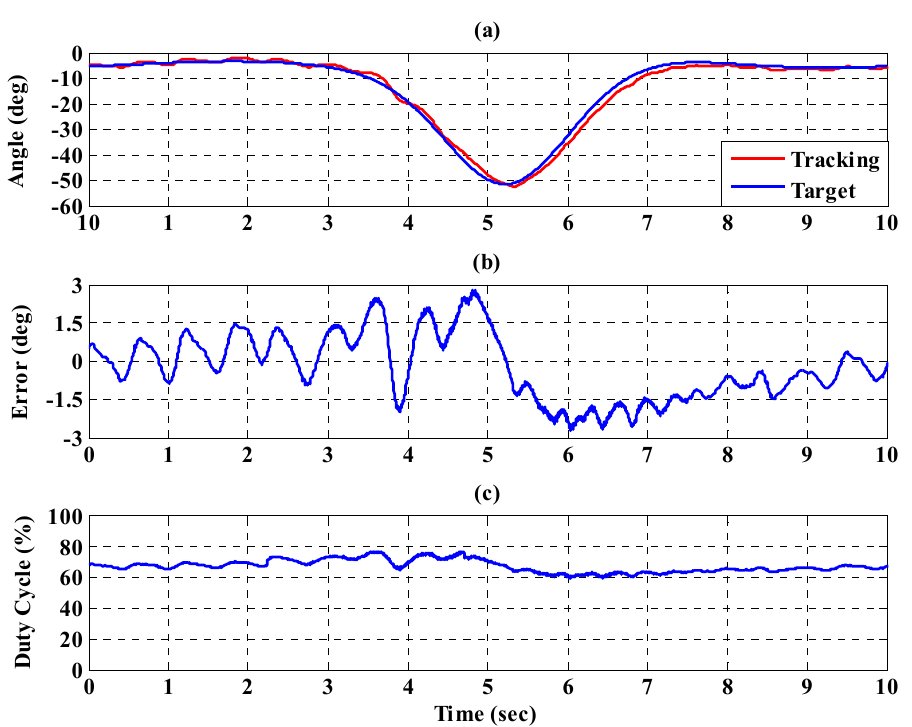
Figure 19. Tracking response of the interval type-2 fuzzy sliding pulse-width modulation controller on the left knee for the PGOS. ( a ) output response; ( b ) tracking error; ( c ) pulse-width modulation control signal.